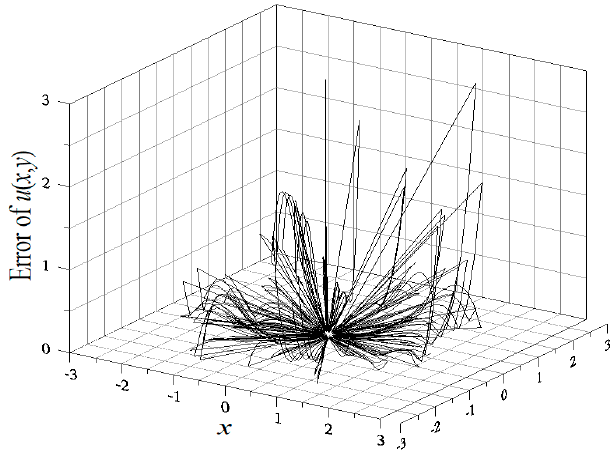
Figure 7. The numerical errors of the proposed method solution for the steady-state AC equation with gear irregular domain.